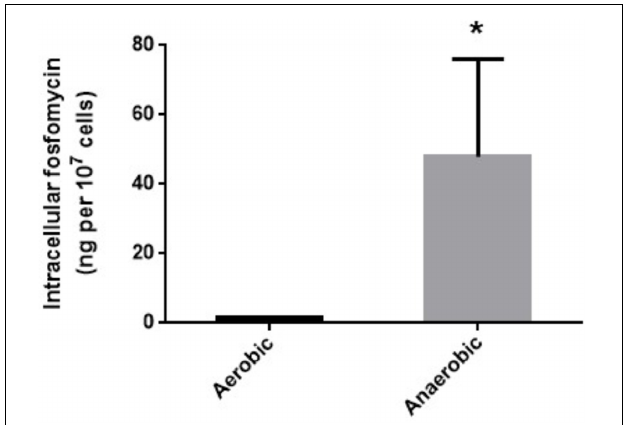
FIGURE 1 | Intracellular accumulation of fosfomycin in PAO1 grown under aerobic or anaerobic conditions. Accumulation was described as amounts of fosfomycin (ng) in 10 7 cells. Data plotted are the means from three independent experiments; error bars indicate the standard deviations, ∗ P < 0.05. Asterisks denote significance for values of intracellular fosfomycin amount in bacterial cultures under anaerobic conditions relative to those under aerobic conditions.